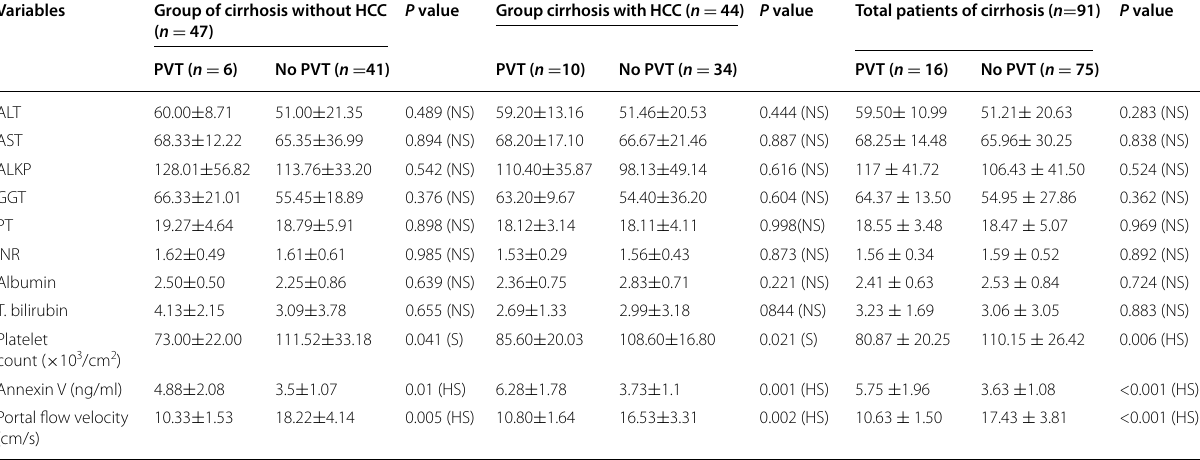
P value for comparing between all groups. Values are expressed as mean *: statistically significant at p <